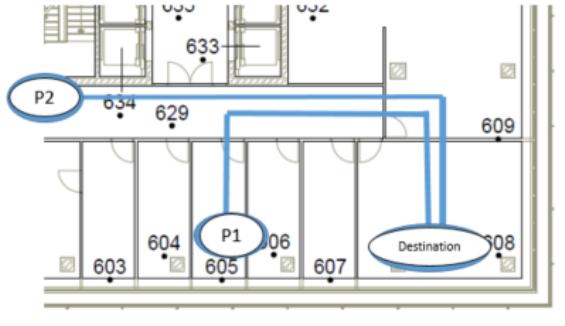
Figure 6: Experimental path